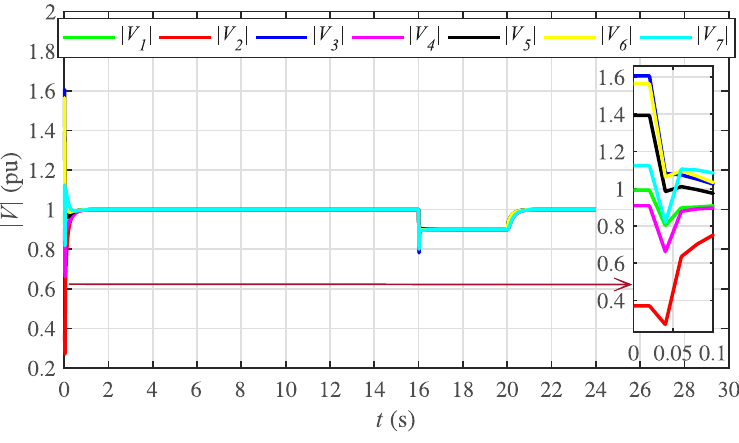
Fig 37. Voltage regulation with leader-follower and leaderless consensus under case